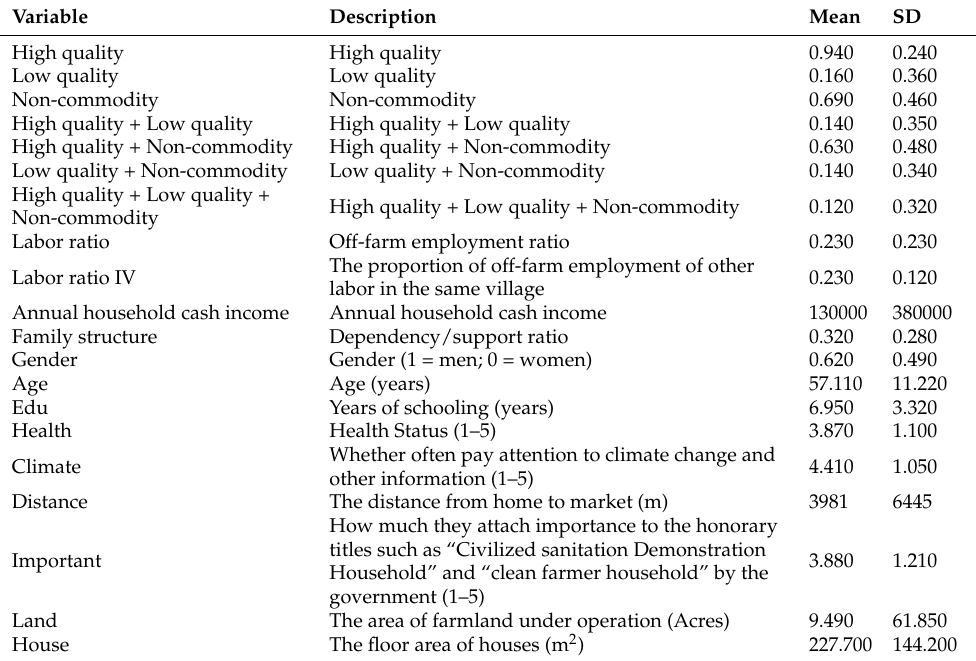
Table 1. Descriptive